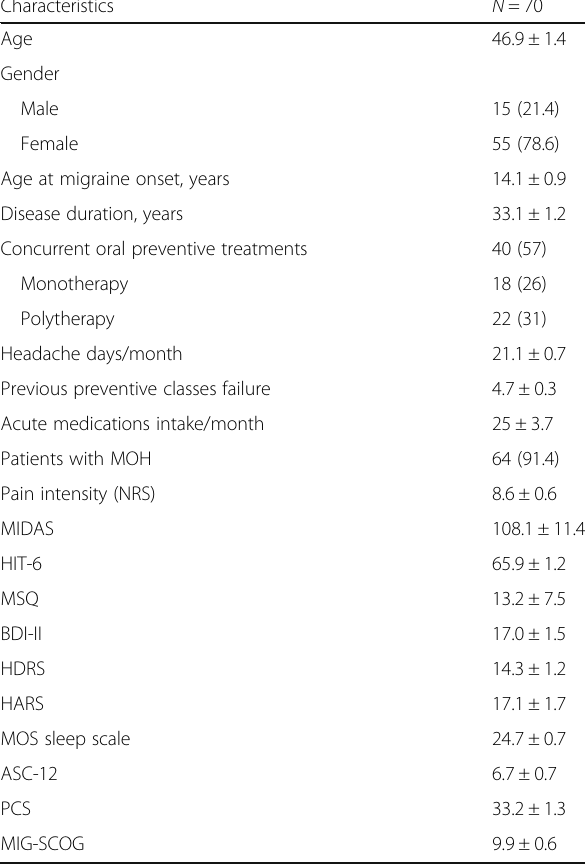
Table 1 Baseline demographic and clinical parameters Characteristics